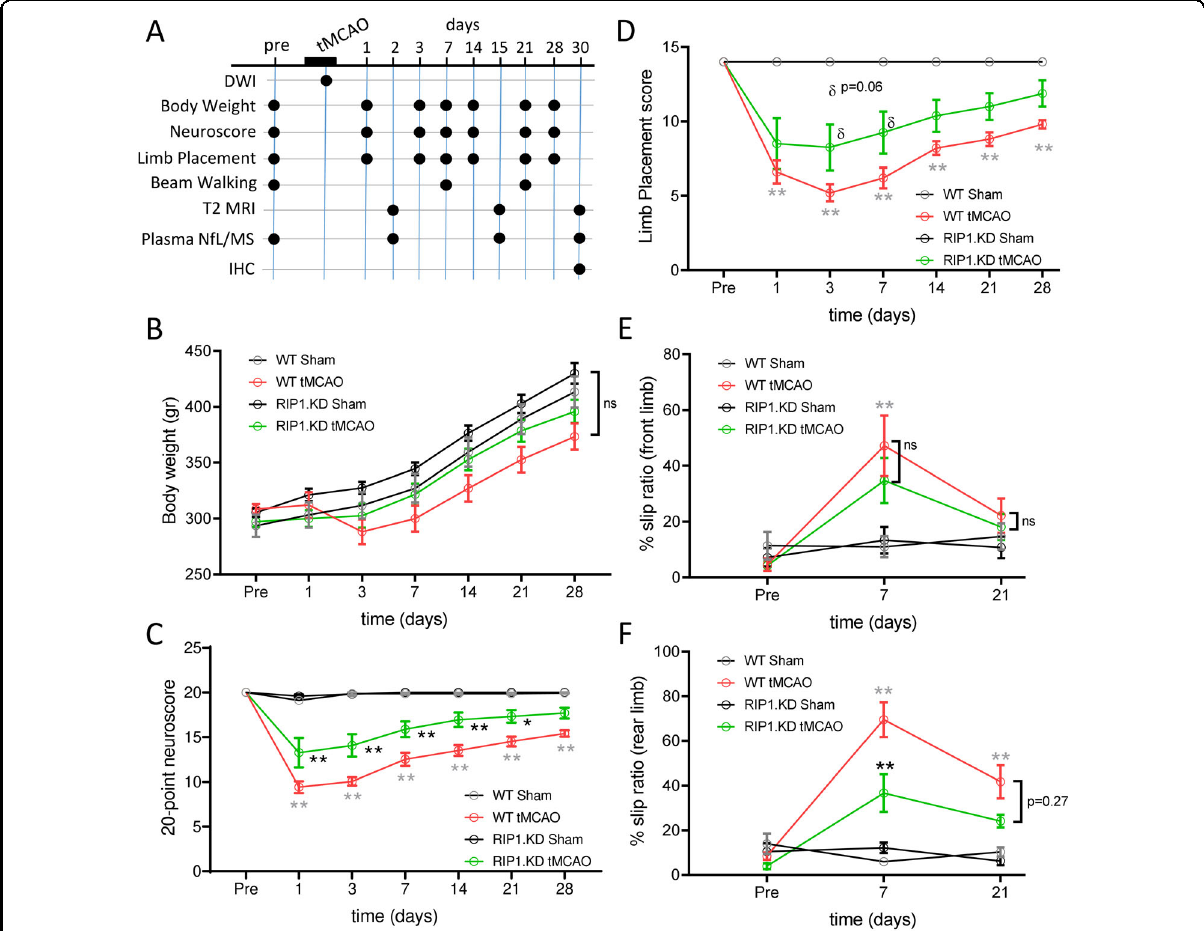
Fig. 2 Genetic inactivation of RIP1 kinase activity ameliorates neurological function following ischemic brain injury. A Experimental timeline and endpoints in the tMCAO model. B Body weights of WT and RIP1 KD rats before and after sham or tMCAO surgery. C – F Behavioral scoring of WT and RIP1 KD rats before and after sham or tMCAO surgery. 20-point neuroscore ( C ), limb placing ( D ), and beam walking (forepaw ( E ) and hindpaw ( F )) tests were performed. n = 8 – 10 rats/group. At the indicated time points, ** p < 0.01 between WT-tMCAO and WT-Sham (in gray), and * p < 0.05 and ** p < 0.01 between RIP1 KD-tMCAO and WT-tMCAO (in black) by Three-Way ANOVA (Holm-Sidak). Data are represented as mean ±